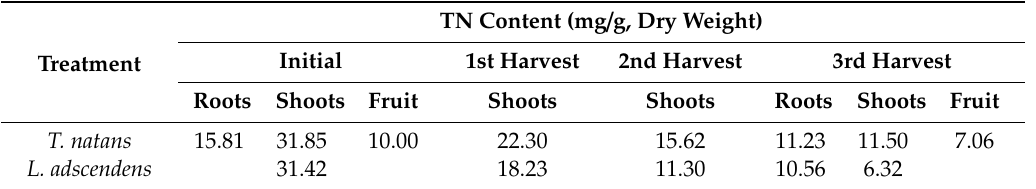
Table 2. Total nitrogen (TN) concentration and total uptake of floating aquatic macrophytes after 60 days of treatment in swine manure wastewater (mg / g, dry weight).